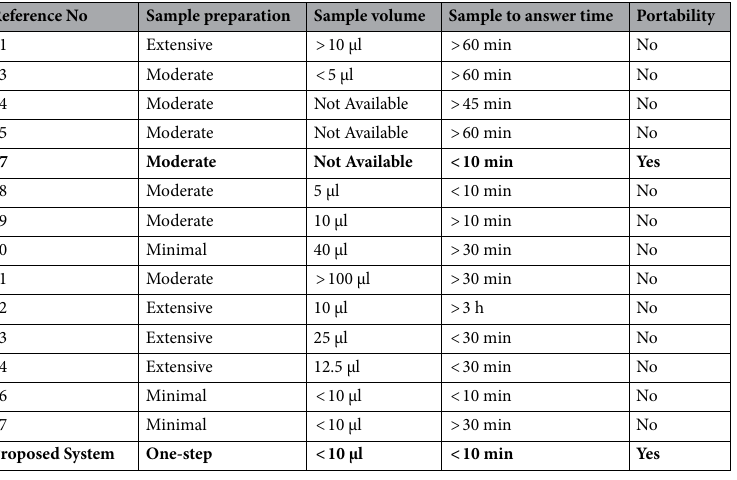
Table 1. A tabular comparison of the sample preparation, sample volume, sample to answer time, and portability of sensor systems. Significant values are in